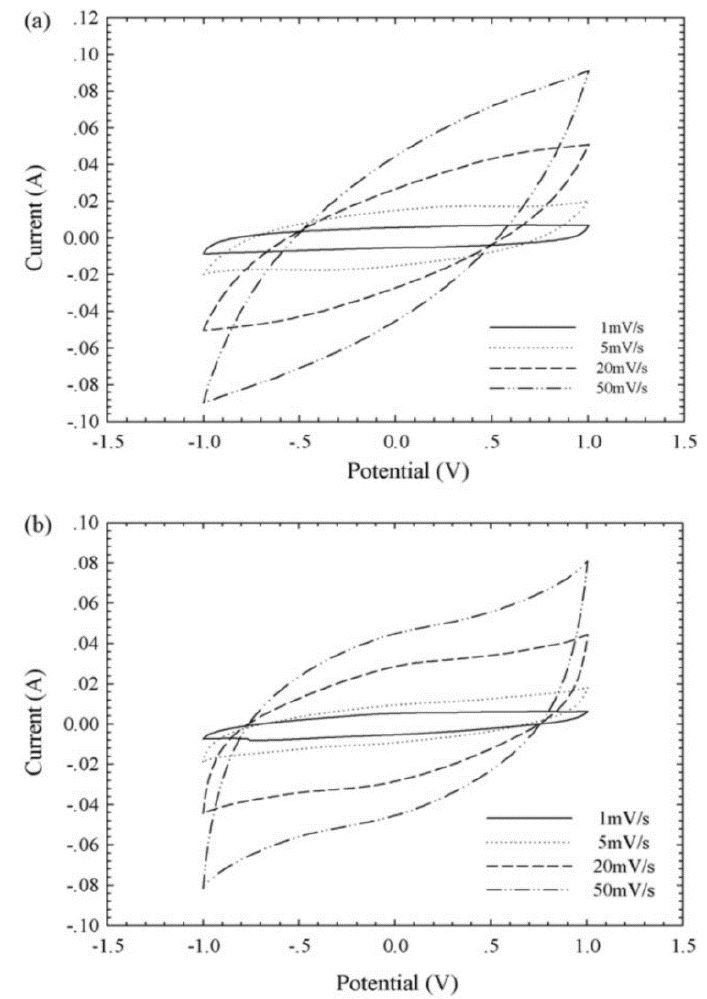
Figure 30. Cyclic voltammograms of CA(BA-teta) ( a ) and CA(BA-a) ( b ) with scan rates of 1, 5, 25, and 50 mV/s (reproduced from the work in [89] with permission).